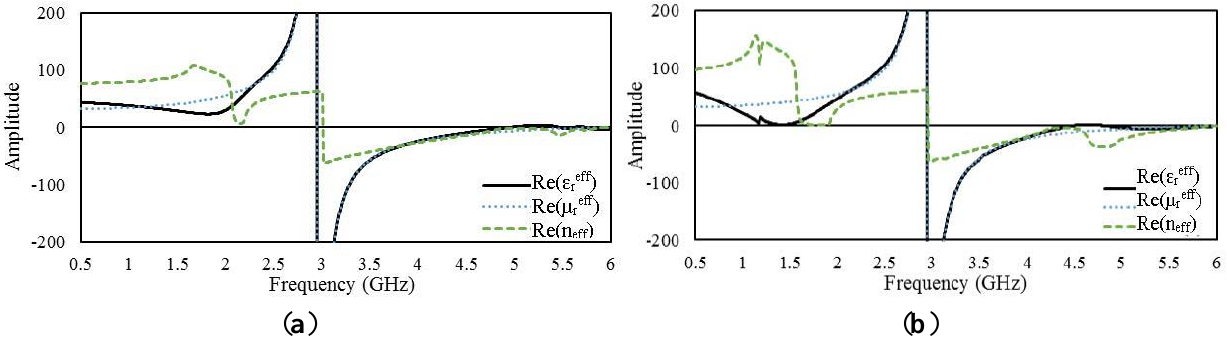
Figure 6. Real parts of the effective parameters of 2 × 2 arrays of unit cell A: ( a ) open array and ( b ) interconnected array.